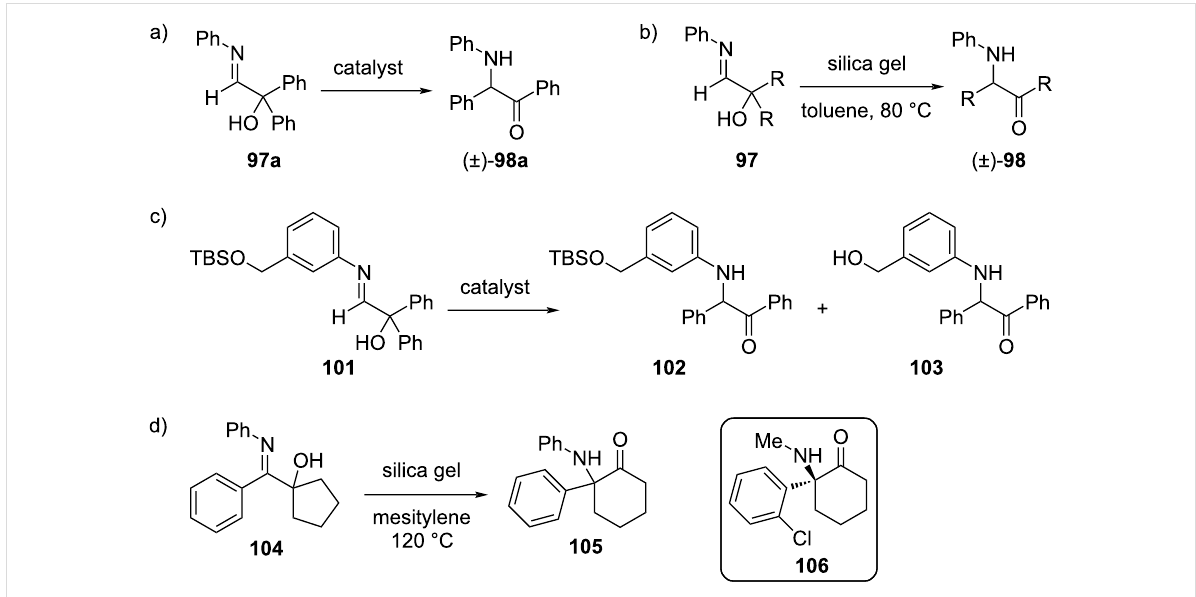
Figure 19: α -Iminol rearrangements catalyzed by silica gel and montmorillonite K 10. a) For 102a ( 102 with R = Ph), silica gel and montmorillonite K 10 gave ≥ 95% yields, while Brønsted acids, other Lewis acids, and NaOEt generally performed much more poorly. b) Electron-rich R groups rearrange efficiently in the presence of silica gel but not the electron-deficient p -trifluoromethylphenyl derivative. c) In the presence of silica gel or montmorillonite K 10, TBS-protected 101 is converted to 102 without any side products, but when sulfuric acid is used, only the deprotected product 103 is detected. d) Silica gel-catalyzed rearrangement of 104 provided 105 , an analogue of the anesthetic ketamine ( 106 ).